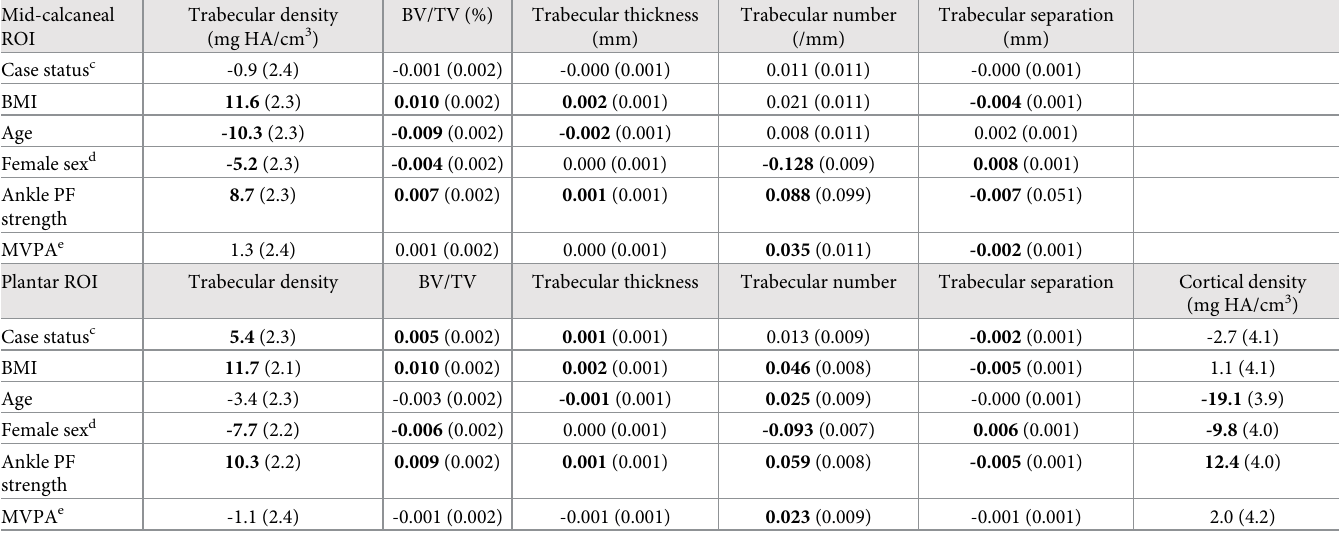
Table 3. Univariable results for mid-calcaneal and plantar ROI, standardized co-efficients(se) a,b . Mid-calcaneal